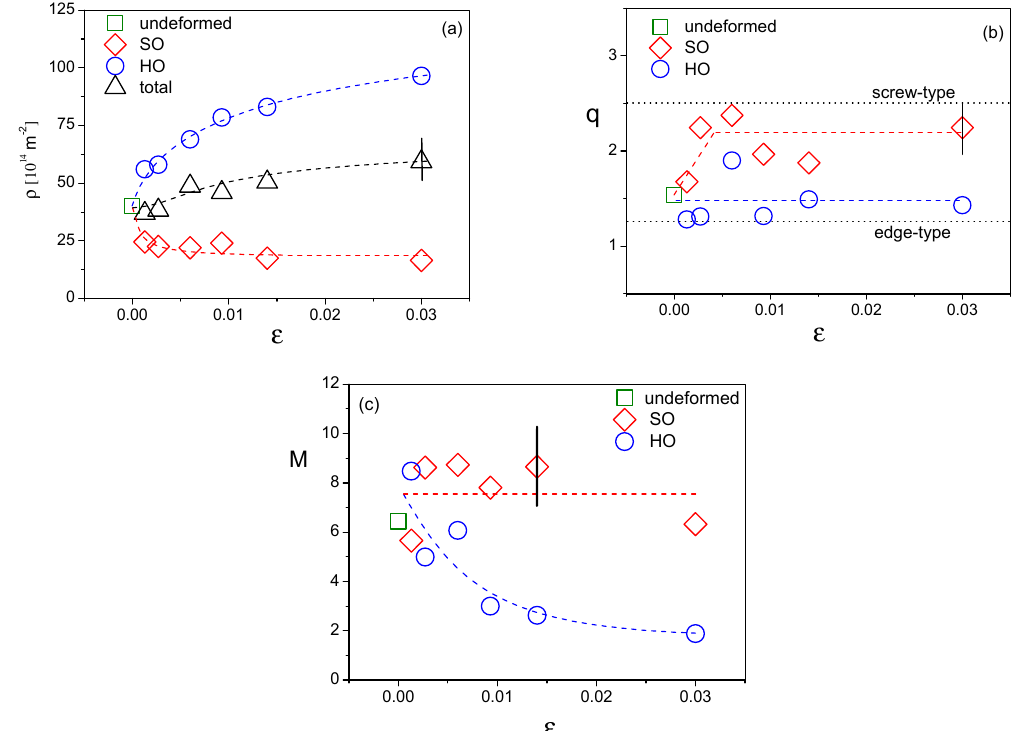
Figure 8. The dislocation densities ( a ), the q dislocation-type ( b ) and the M dislocation arrangement parameters ( c ) in the HO and SO packets as a function of true strain. The vertical thick black lines indicate the experimental error.